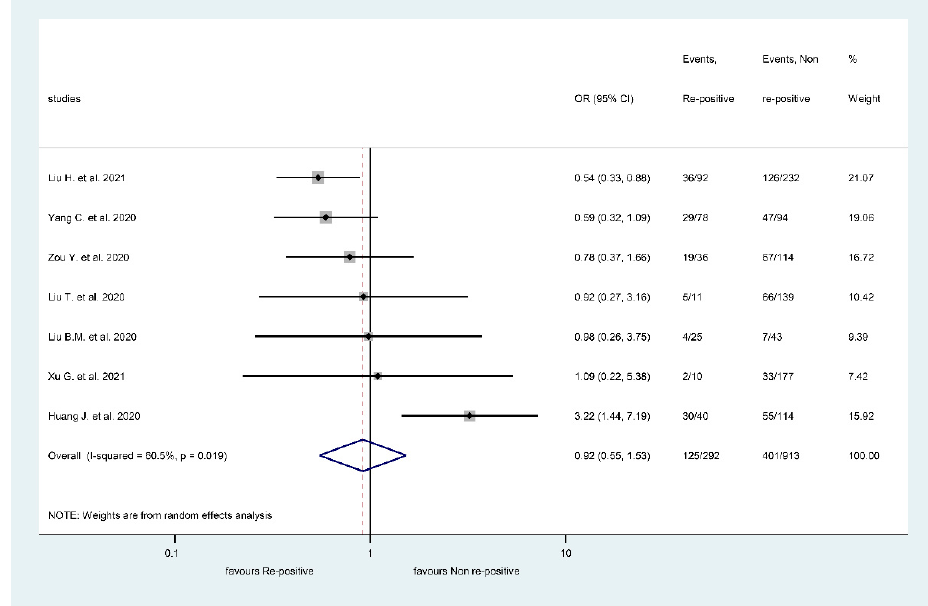
Figure 2. Forest plot representing that repeatedly SARS-CoV-2 positive episode does not significantly impact Immunoglobulin M’s presence.